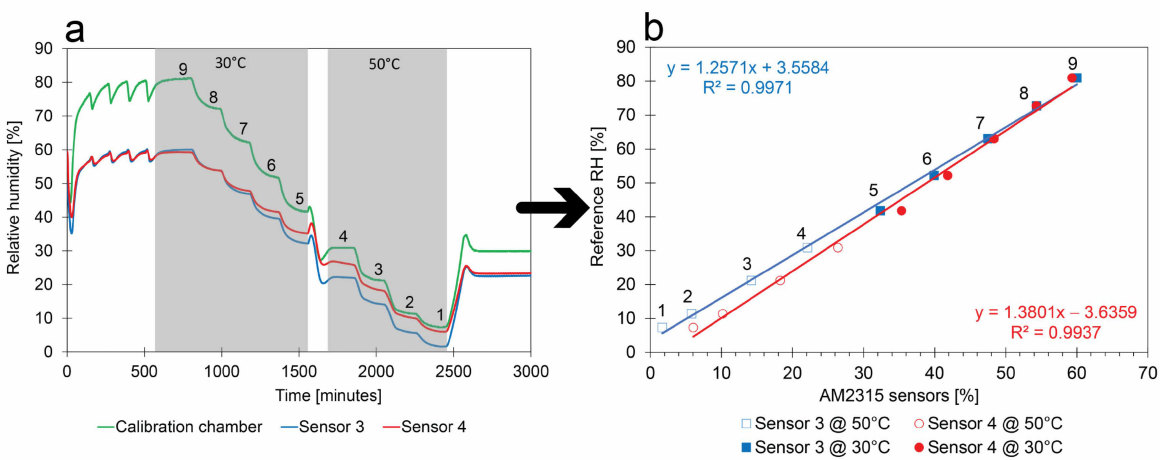
Figure 11. RH calibration of the same AM2315 sensors as in Figure 8 using a state-of-the-art calibration chamber performed in Belgium (moderate marine climate); ( a ) raw data with the moments at the constant T shown in grey; ( b ) calibration curve obtained by processing the numbered